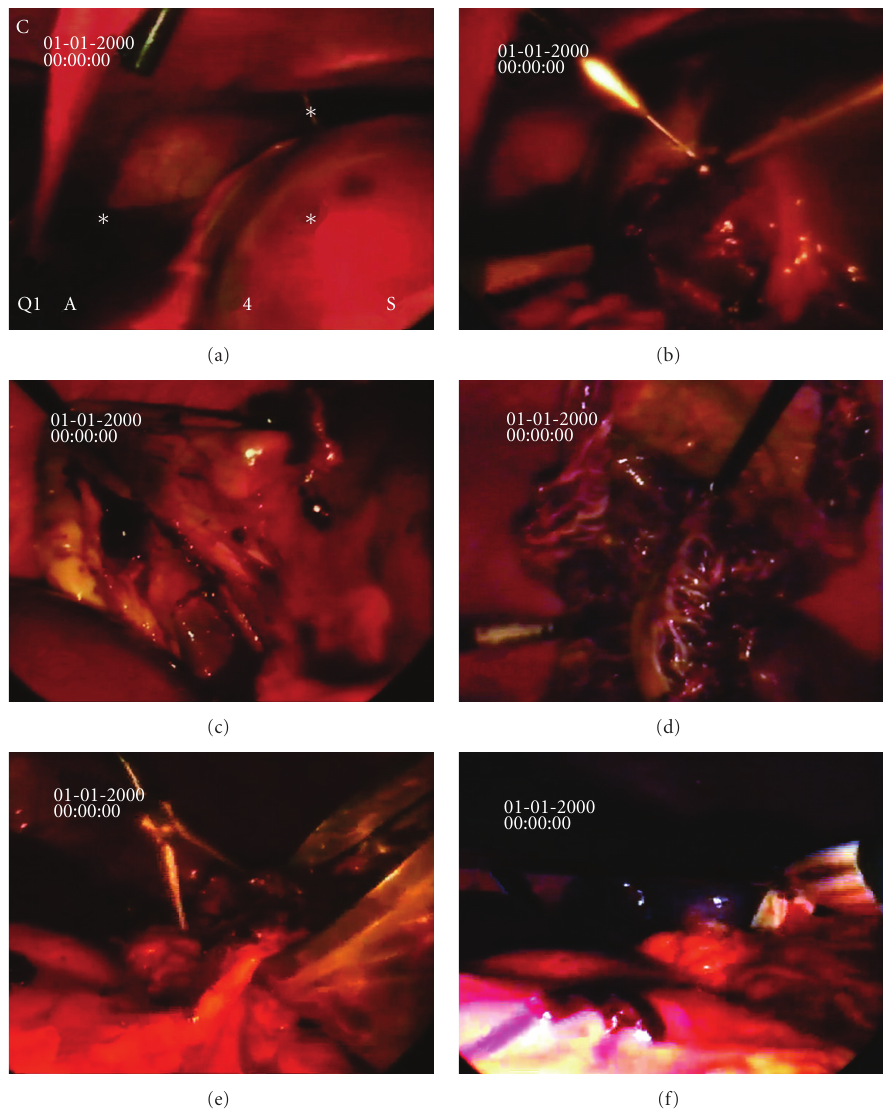
Figure 4: (a)–(f) Laparoscopic view of the splenic cyst during operation. A large splenic cyst located at the upper pole of the spleen was found, and its contents were aspirated laparoscopically (a & b). Laparoscopic resection of the cyst wall and partial decapsulation with a large window was performed (c & d). The resected cyst wall was removed in an ENDOBAG (e). A drain was placed in the cyst remaining cavity